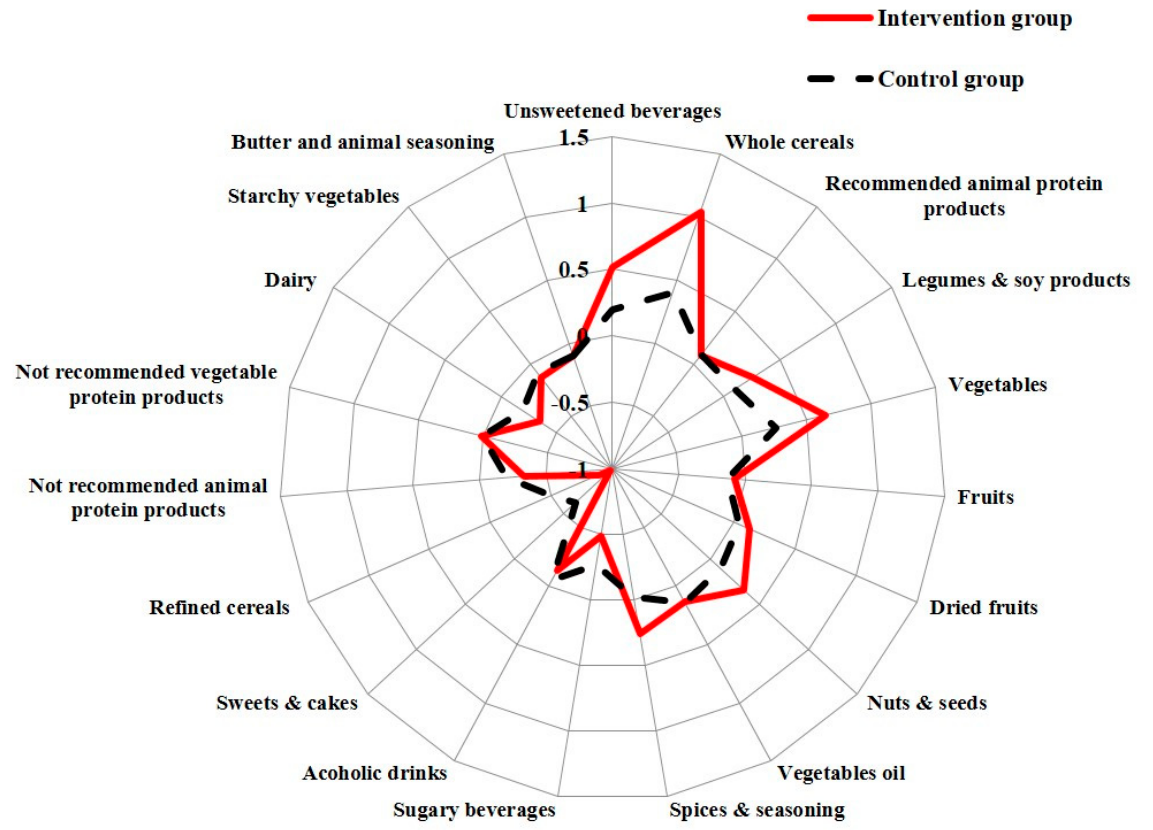
Figure 2. Changes of food frequencies consumption by randomization group. The distribution of the “Delta, ∆ ” change in frequencies of food consumption (time/day) in the intervention group and in the control group is represented by a Kiviat diagram. This graphic representation consists of a sequence of rays that originate from a center and forms equal angles to each other; each ray represents one of the food/food group variables. The distance from the center of the point marked on the radius is the “Delta, ∆ ” change of frequencies of food/food group consumption (time/day). The points on the rays are joined with two segments, red and continuous for the intervention group and dashed for the control group.